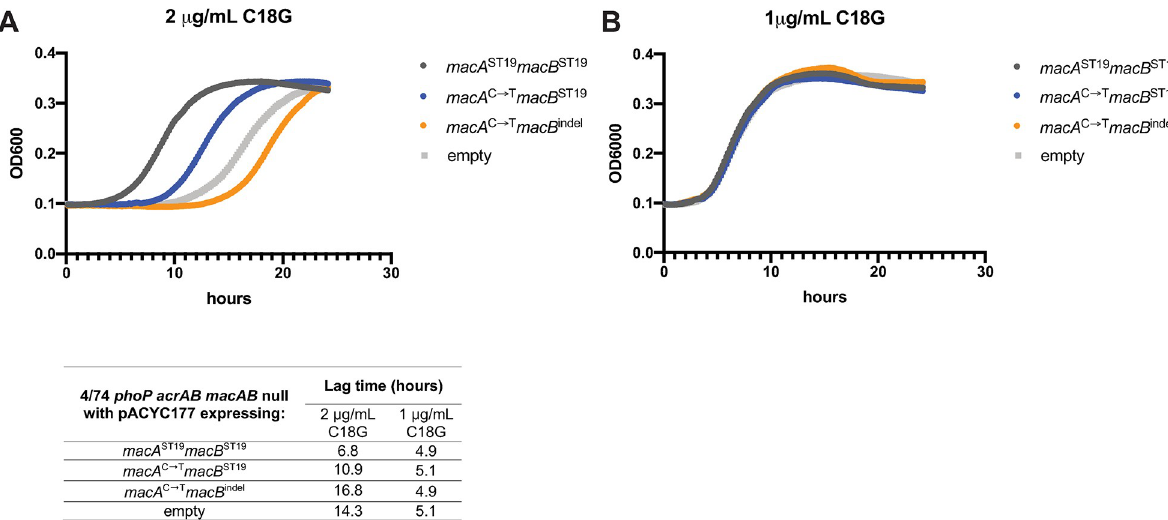
Fig 4. S . Typhimurium ST19 macAB provides superior resistance to the antimicrobial peptide C18G. 4/74 phoP acrAB macAB null mutants with low-copy pACYC177 plasmids constitutively-expressing macAB variants (pJH14-17, see S3 Table) were grown in N minimal medium, pH 7.4 and 1mM MgCl 2 . Overnight stationary phase cells were washed and normalized to OD600 = 1 before 1:200 final dilution into fresh N minimal medium with 2 μ g/mL C18G (A) or 1 μ g/mL C18G (B). OD600 was monitored over time using a BioTek Synergy HTX plate reader. Growth curves presented here are from one experimental run and representative of three independent experiments. Plotted data points are the geometric mean of quadruplicate or triplicate microplate wells. Lag time (inset table) was determined as time to reach OD600 = 0.15.